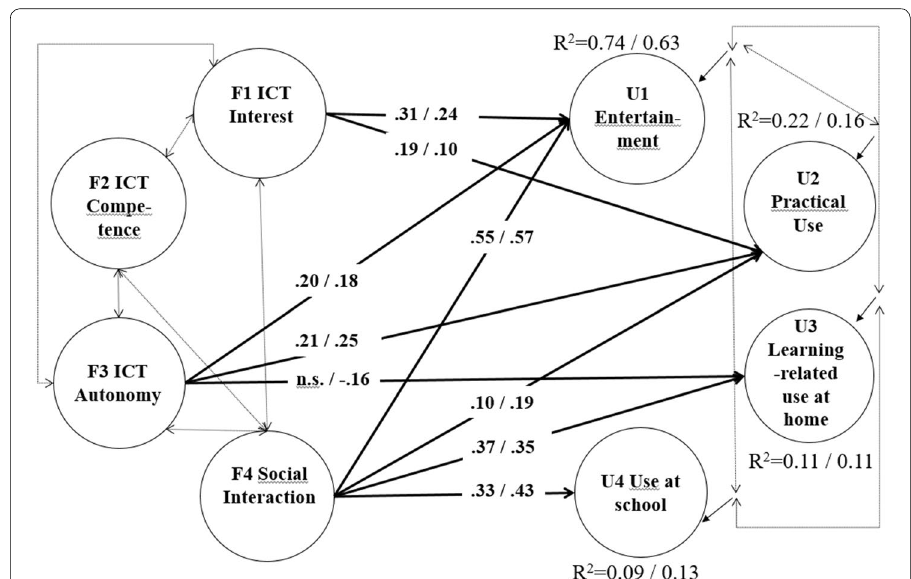
Fig. 3 Structural part of the final latent regression model with ICT Engagement factors explaining variance in ICT Usage factors. The coefficients in front of the forward slash refer to values for the Swiss sample, whereas the values after the forward slash refer to the results for the German sample. For a greater clarity only significant regression coefficients ( p < 0.001) are shown in the figure. Model fit for Switzerland: χ 2 df